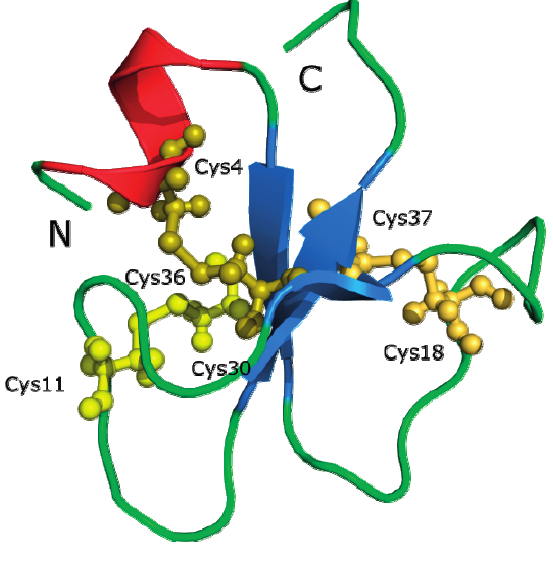
Figure 8. The crotamine chemical structure. Crotamine, a Na+ channel-affecting toxin from Crotalus durissus terrificus venom (PDB 1H5O)